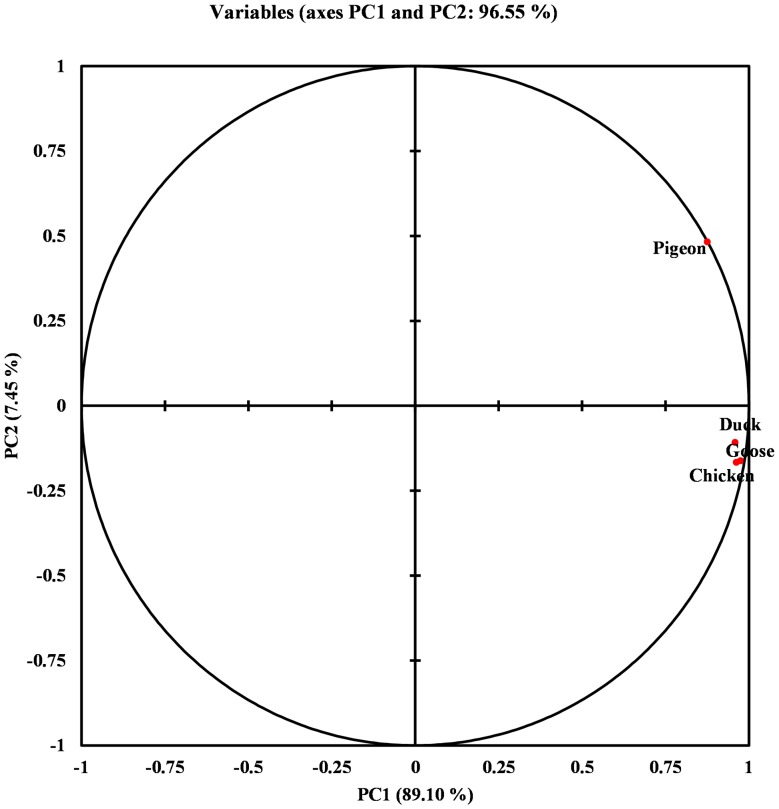
Relatedness among the species based on the codon usage.Chicken, Goose and Duck are more related in terms of codon bias than Pigeon which is an outlier.